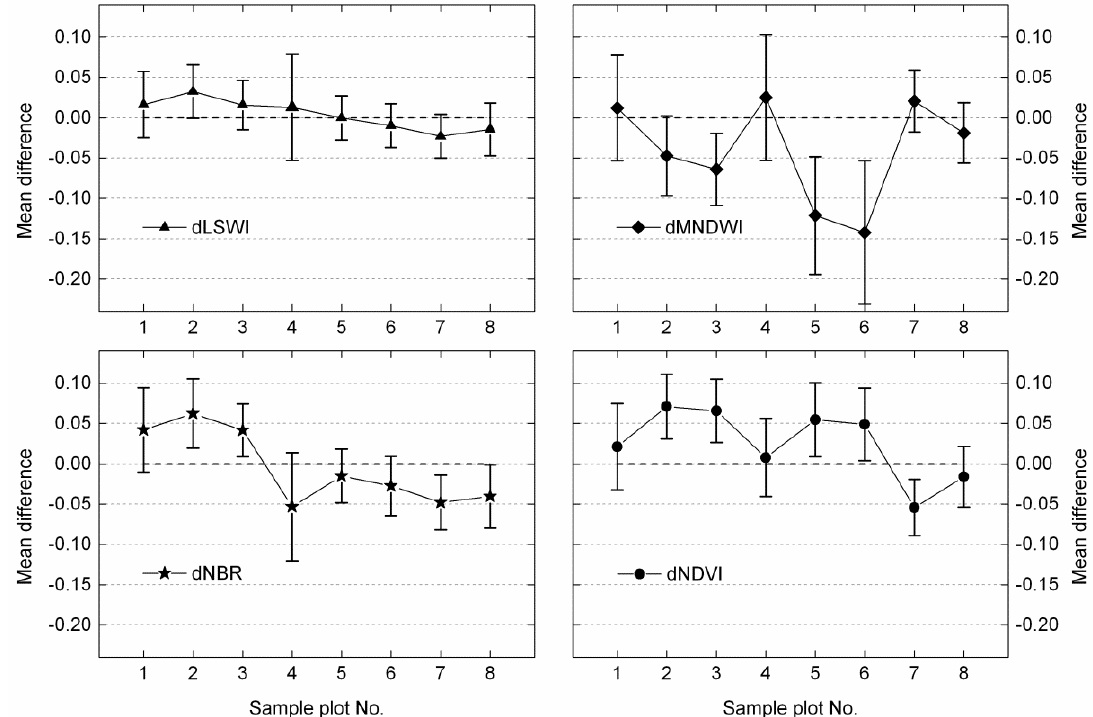
Figure 7. Mean values and standard deviation of differenced vegetation indices (dLSWI, dMNDWI, dNBR and dNDVI) derived from Landsat-7 ETM+ images (25 March 2013 and 1 April 2013) and Landsat-8 OLI images (27 March 2013 and 3 April 2013) within eight sample plots. LSWI, Land Surface Water Index; MNDWI, Modified Normalized Difference Water Index (MNDWI); NBR, Normalized Burn Ratio; NDVI, Normalized Difference Vegetation